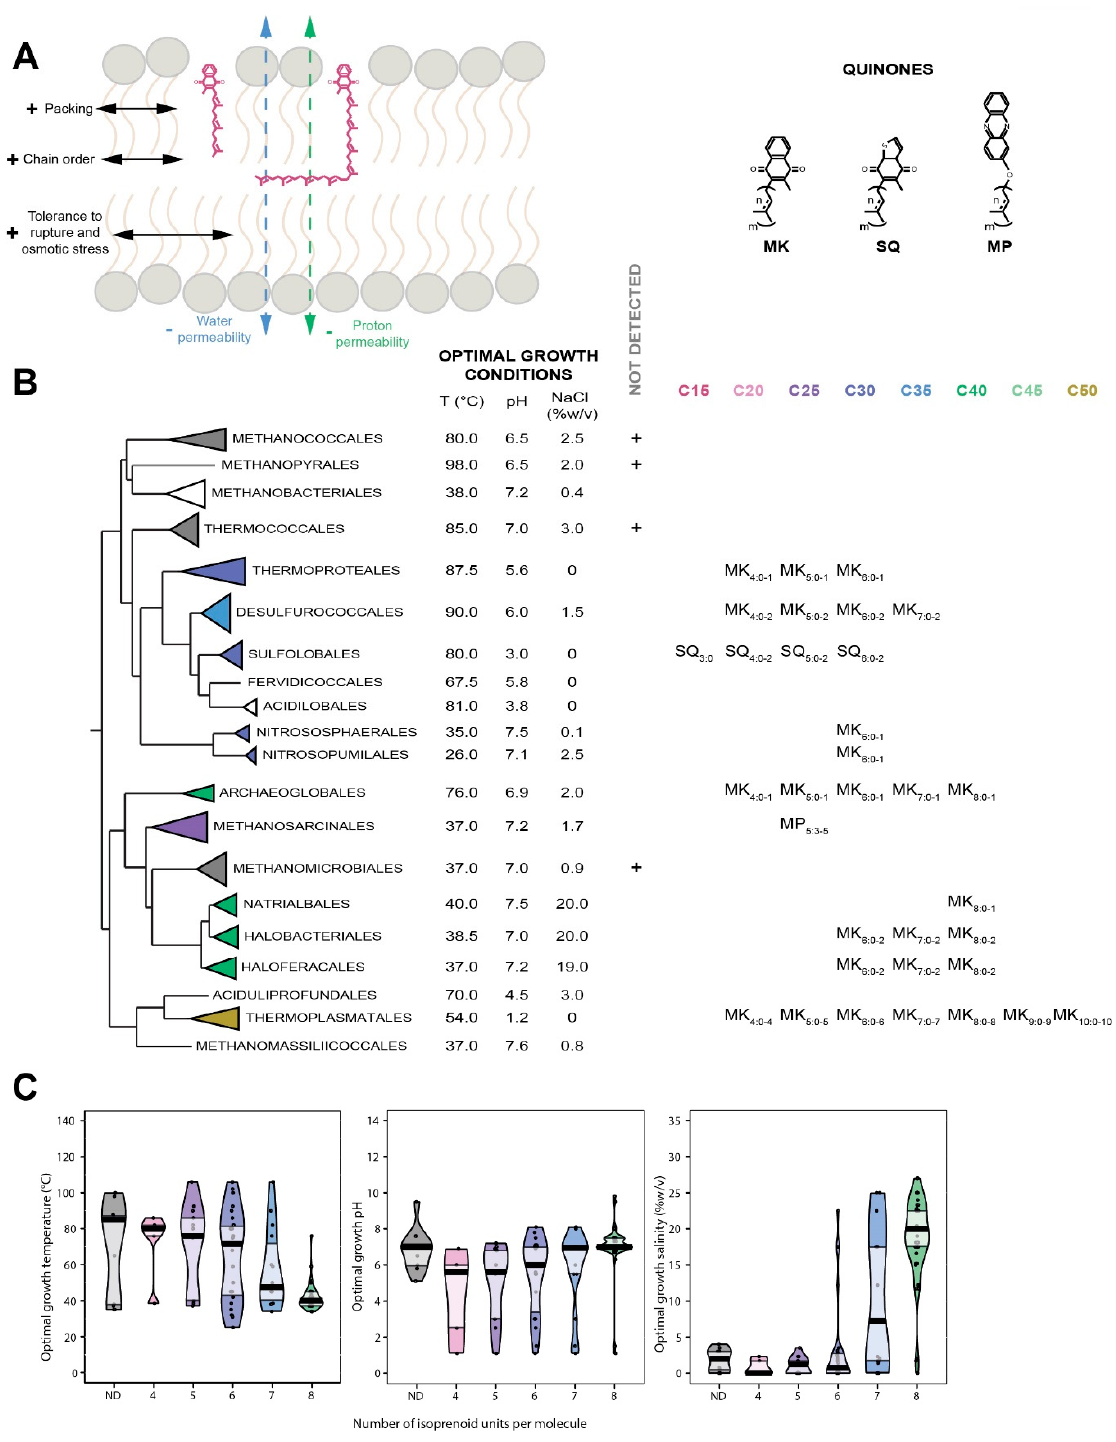
Figure 4. Physicochemistry, distribution and adaptive response of quinones in Archaea. ( A ), Position and impacts of quinones on membrane physicochemical properties. ( B ), Structures and distribution of quinones within the Archaea domain. The tree topology has been adapted from [34]. The different chain lengths are represented and the polar heads and insaturation degrees are indicated. ( C ), Pirateplot of the optimal growth conditions of the organisms in which the different side chain lengths of quinones were detected. Colors indicate the quinone apolar chain lengths as in B. Abbreviations: MK, menaquinone; SQ, sulfolobusquinone; MP, methanophenazine. EURY1, Euryarchaeota cluster I; PROTEO, Proteoarchaeota; EURY2, Euryarchaeota cluster II.